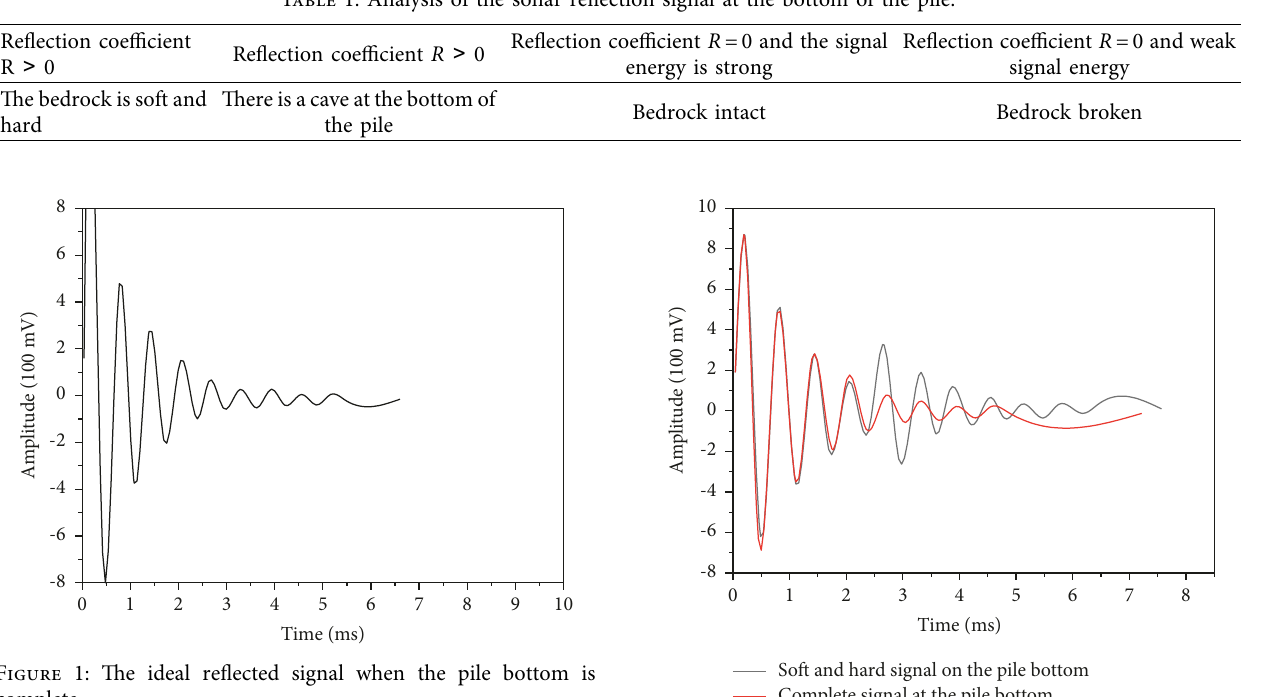
Table 1: Analysis of the sonar reflection signal at the bottom of the pile.